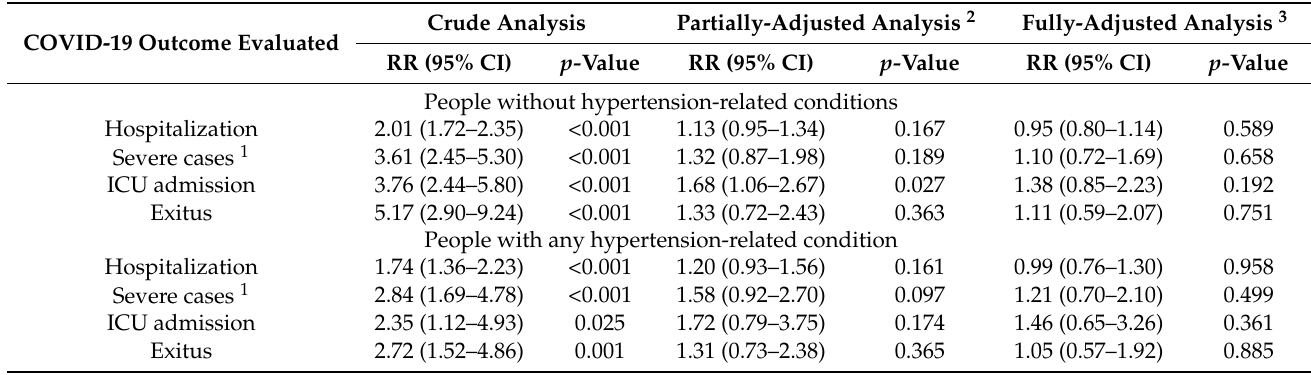
Table 4. Effect of hypertension on the risk of hospitalization, severe outcomes 1 , admission to intensive care unit (ICU) or death for COVID-19 by the presence of any hypertension-related conditions (cardiovascular, cerebrovascular or chronic kidney diseases).